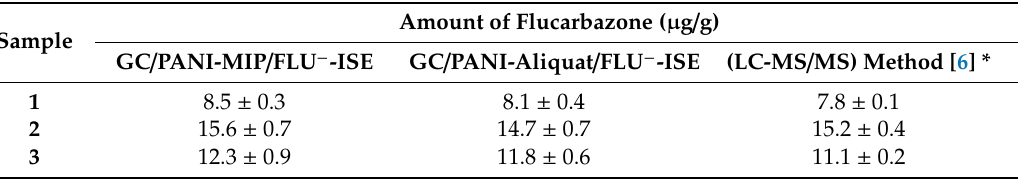
Table 3. Potentiomeric determination of flucarbazone in di ff erent soil